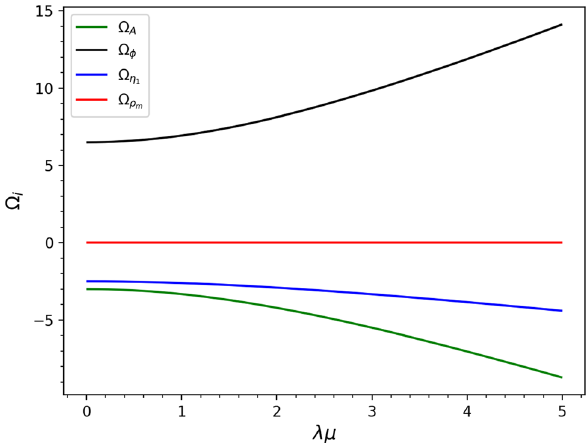
Fig. 5 The figure illustrates the relation between density parameter of non-vanishing fields and free parameters, i.e., λ and μ , for F point.Notedthatthegreen,black,blueandredlineinthegraphindicates (cid:12) (cid:12) φ , (cid:12) η and (cid:12) ρ , A , m 1